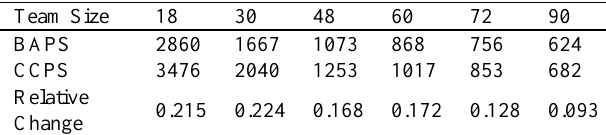
Table 2. Global average idleness from simulation with BAPS